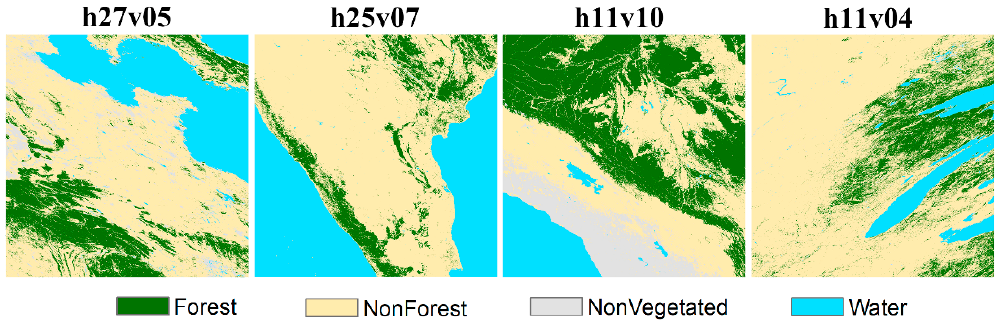
Figure 5. Forest cover maps derived with the proposed method in 2010 for h27v05, h25v07, h11v10 and h11v04.